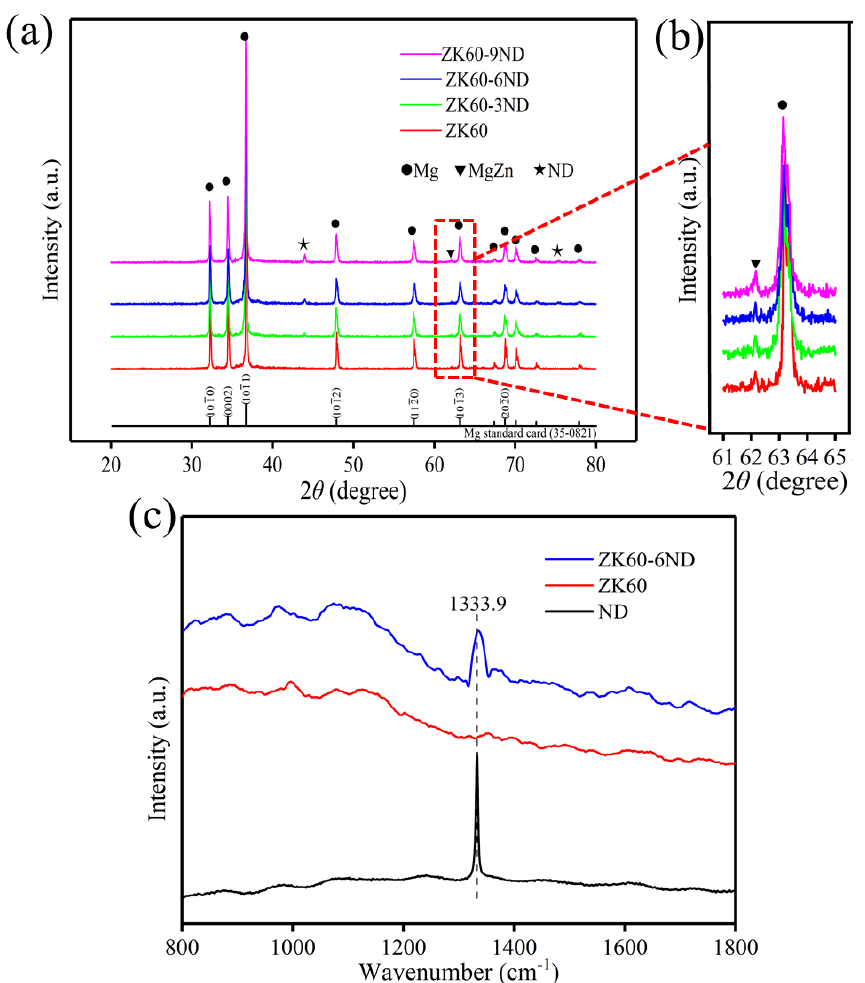
Figure 3. ( a ) The XRD pattern of SLMed ZK60 − xND; ( b ) the enlarged area of the XRD pattern (2 θ = 61–65 ◦ ); ( c ) Raman spectrum of SLMed ZK60, SLMed ZK60 − 6ND as well as the original ND. The composition and distribution of SLMed ZK60 and SLMed ZK60−6ND were analyzed by SEM-EDS, as shown in Figure 4. The SLMed ZK60 is composed of a gray α-Mg matrix and a white secondary phase (Figure 4a). The white secondary phase in ZK60 is sparsely distributed along the grain boundaries and has an island-like structure. The EDS results show that the white island-like second phase (point 1 in Figure 4a) consists of Mg (69.86 at.%) and Zn (30.14 at.%). Combined with the XRD results, it is indicated that the white island-like second phase is the Mg-Zn phase, while for the ZK60−6ND, the black particles (as pointed by red arrows) are observed (Figure 4c). The EDS map results show that the Mg element is homogeneous in structure, the Zn element is in the white particles at the grain boundaries, and these black particles are rich in C element distributed throughout the structure, indicating that the matrix is composed of the Mg element, and the ND is uniformly distributed in the matrix (Figure 4d,e). The